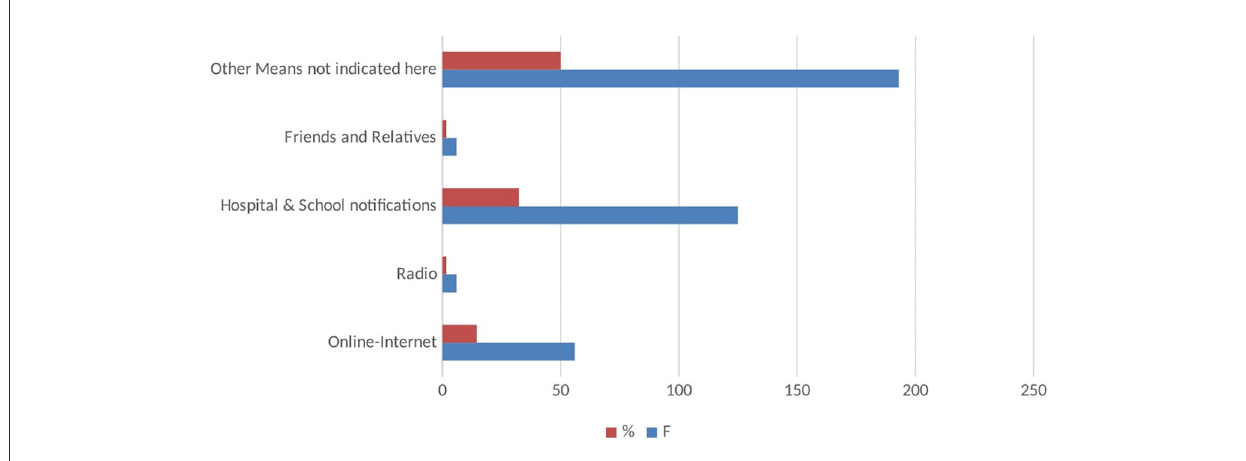
FIGURE3 Sources of information regarding COVID-19.